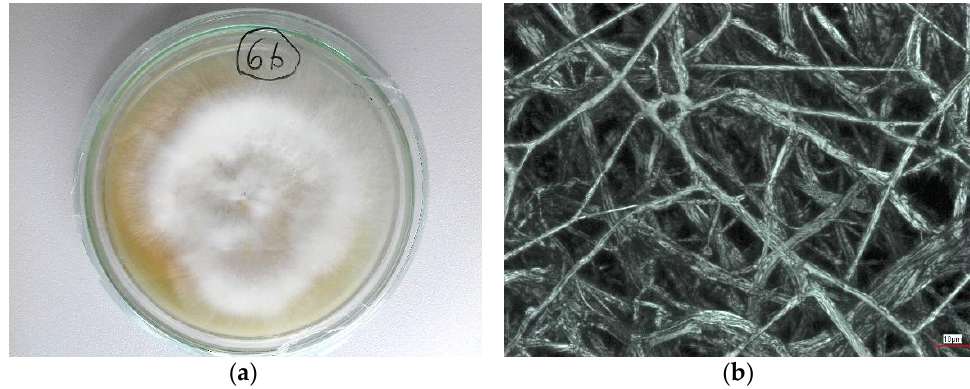
Figure 3. ( a ) Photographs of a fungal mycelium of the fungus Pleurotus ostreatus on agar malt extract and ( b ) confocal laser scanning microscope (CLSM) image of mycelium.